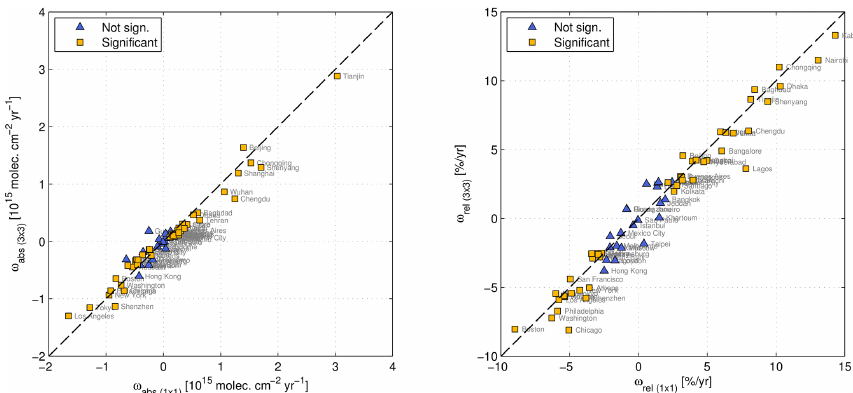
Figure 7. Comparison of absolute (left panel) and relative (right panel) trends calculated using time series extracted from a single SCIA- MACHY grid cell ( ω abs ( 1 × 1 ) and ω rel ( 1 × 1 ) ) and as the average of an array of 3 × 3 SCIAMACHY grid cells ( ω abs ( 3 × 3 ) and ω rel ( 3 × 3 ) ). The markers are further distinguished into trends that are statistically significant at the p < 0 . 05 level (blue triangles) and those that are not (yellow squares).